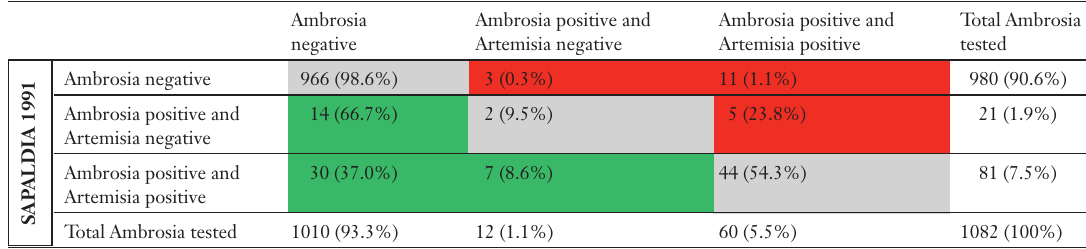
Development of Ambrosia sensitisa- tion between 1991 and 2002 (Geneva and Lugano